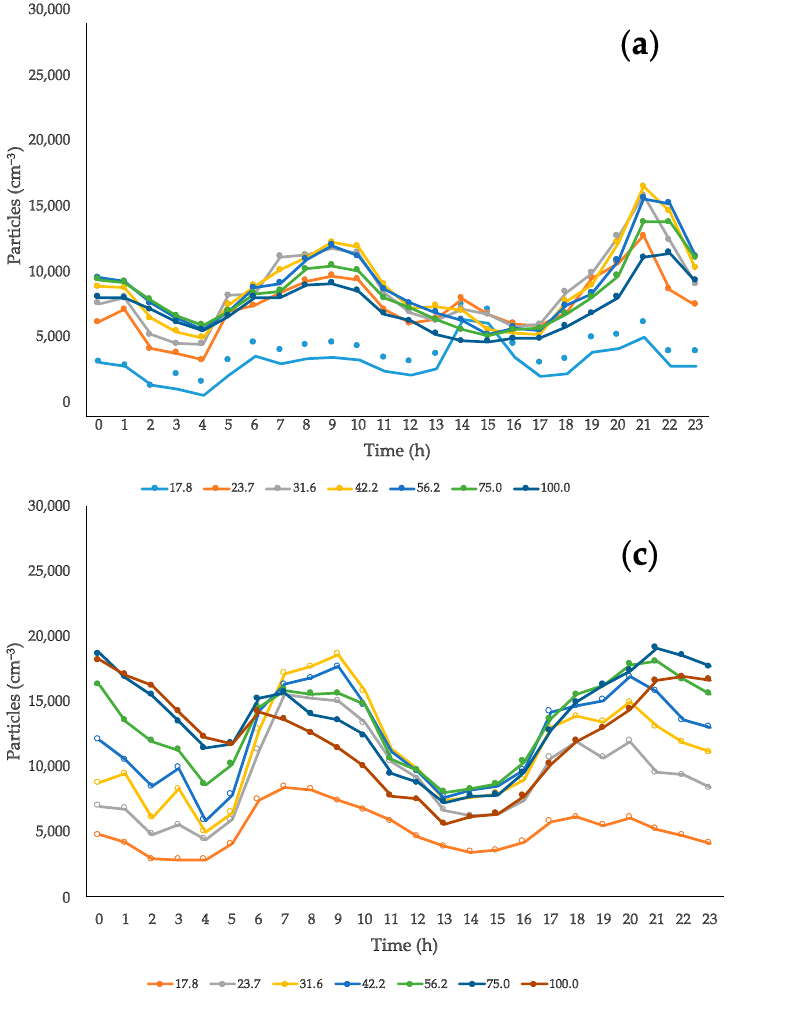
Figure 5. Typical UFP trends during the workday ( a , c ) and weekend ( b , d ) in October and December, respectively.